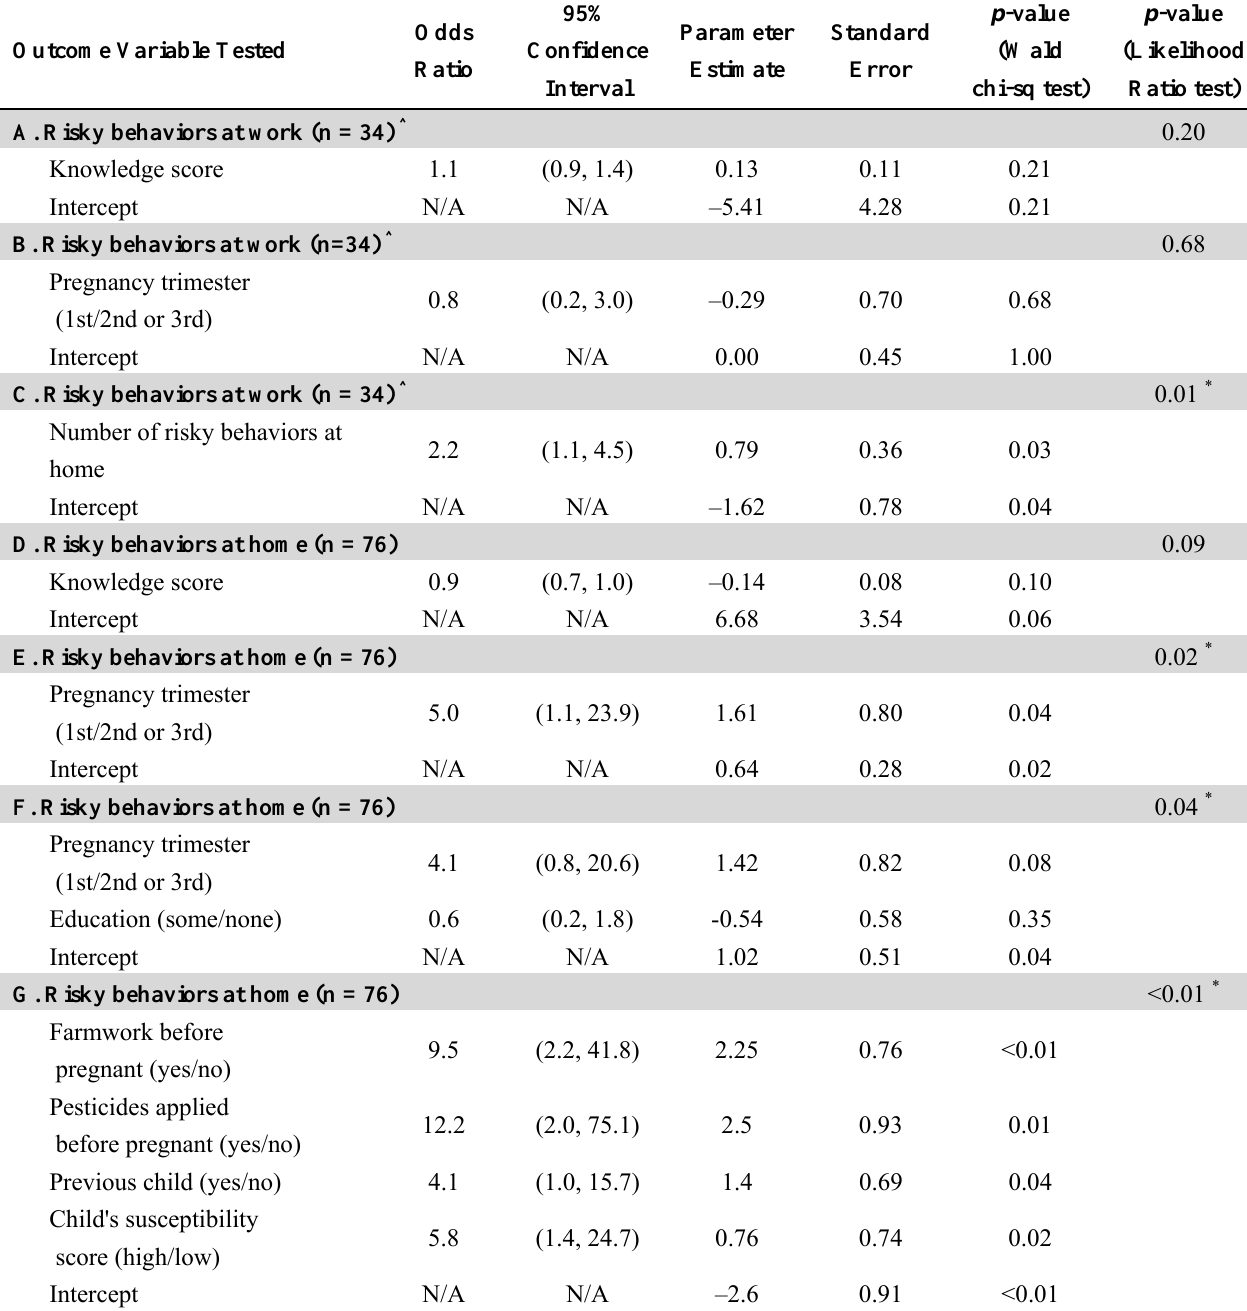
Table 4. Logistic regression model parameters and fit